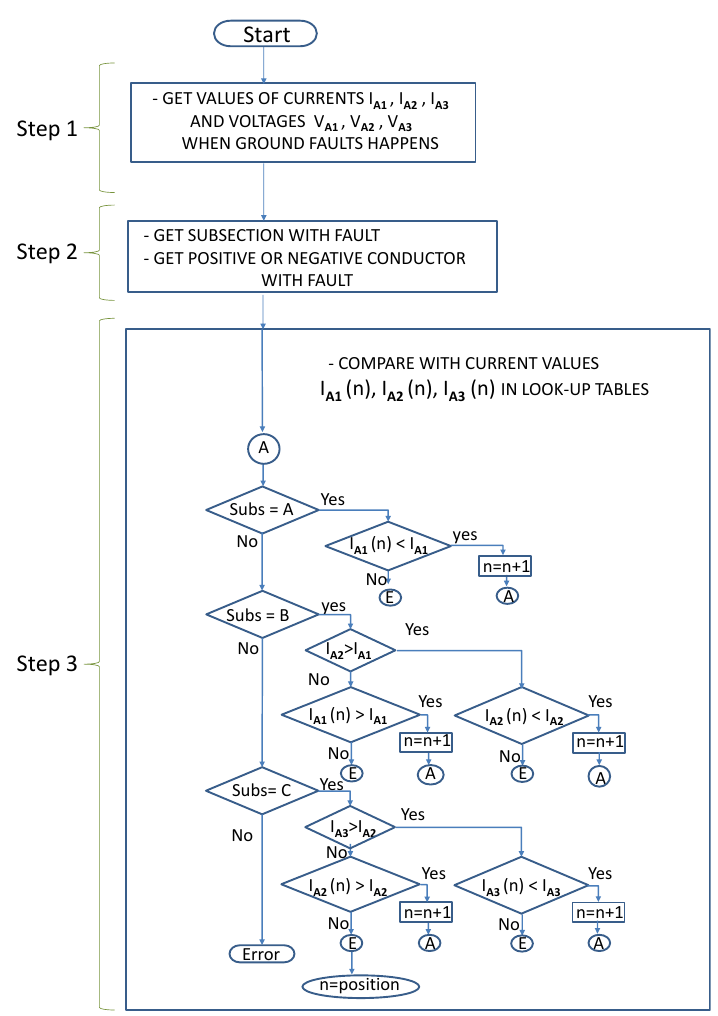
Figure 7. Flowchart of the ground fault location method.